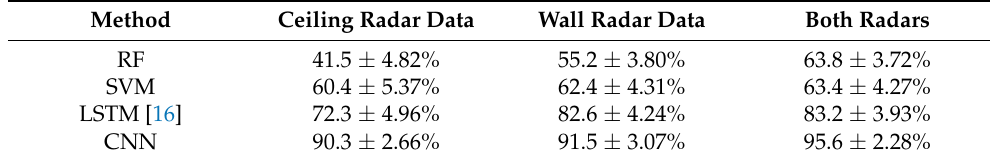
Table 1. Summary of Classification Results.